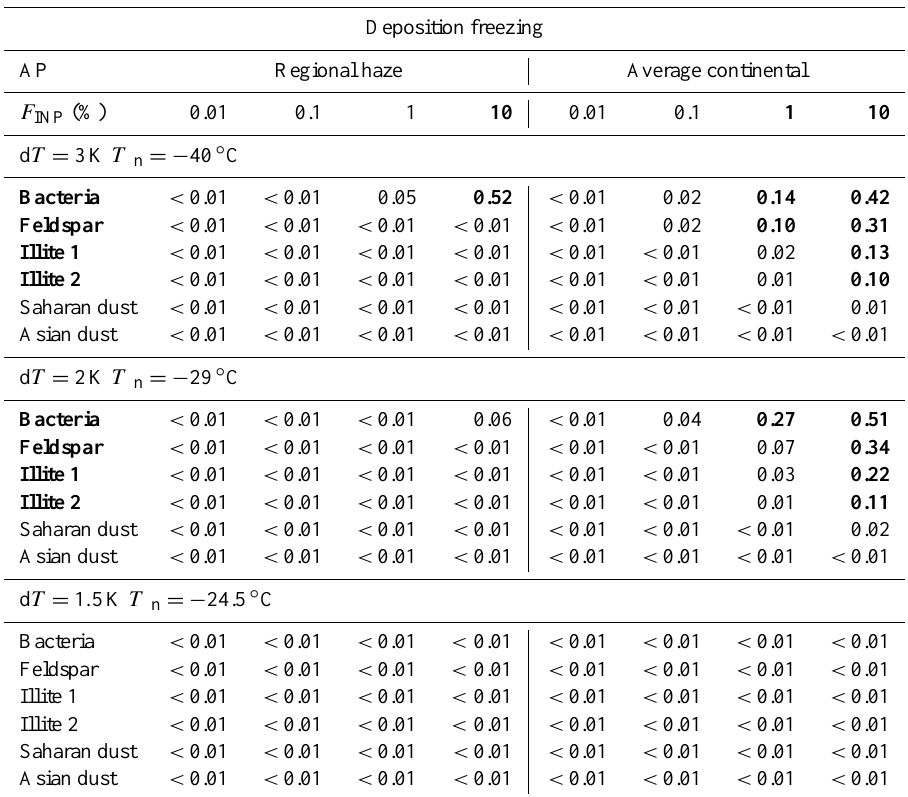
Table 7. Ice water fractions from sensitivity studies with deposition freezing. Liquid clouds: IWF < 0.1, mixed-phase clouds: 0.1 ≤ IWF ≤ 0.9, and ice clouds: IWF > 0.9. Cases referring to mixed-phase clouds and ice clouds are written in